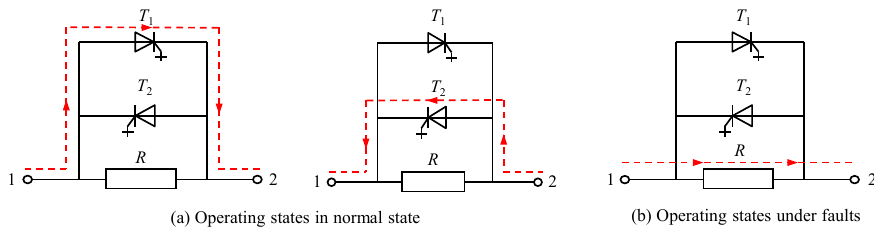
Figure 11. Short circuit current with different inductive fault current limiters.